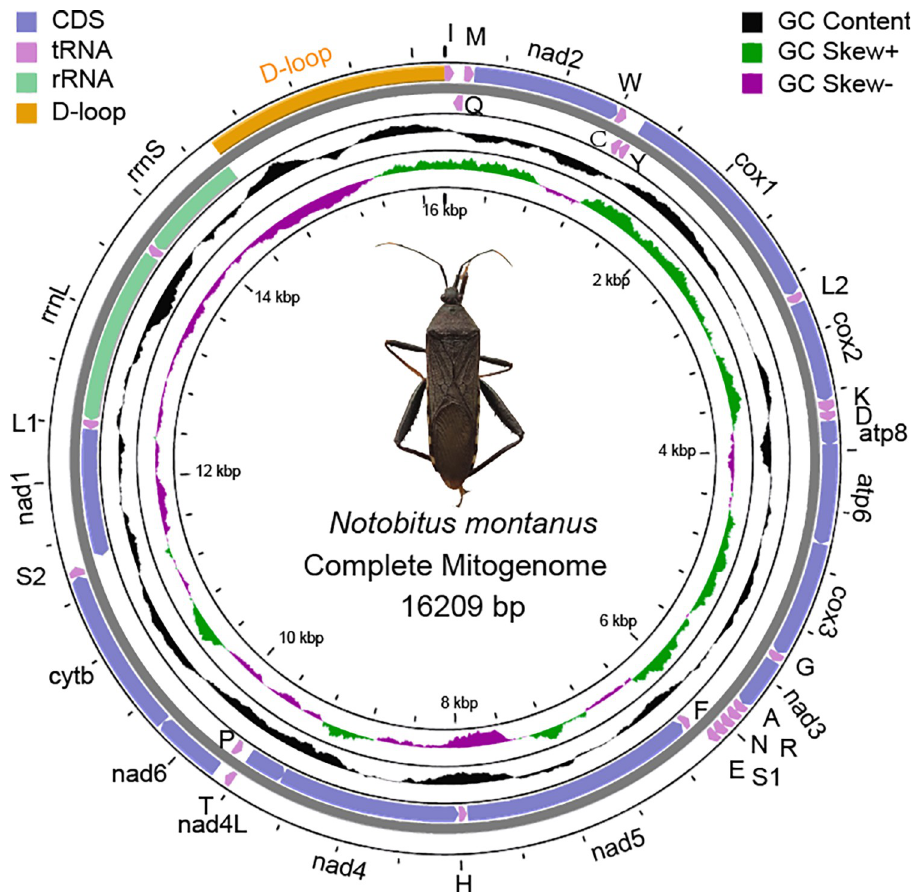
Fig 1. Mitogenome map of Notobitus montanus . Protein coding genes (PCGs, CDS) and ribosomal genes (rRNAs) are presented with standard abbreviations. Genes coding for transfer RNAs (tRNAs) are presented with one letter abbreviation. S1 = AGN, S2 = UCN, L1 = CUN, L2 = UUR. Wathet blue, pink, light green and orange represents PCGs, rRNAs, tRNAs and D-loop (non-coding control region), respectively. Black, green and purple represents GC content, positive GC skew (GC skew+) and negative GC skew (GC skew-), respectively. Gene orientation is indicated by arrows.